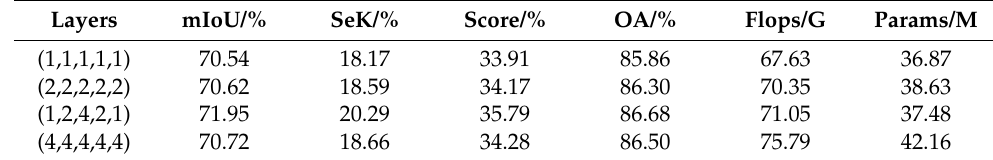
Figure 9. Visual comparisons of ablation experiment on the SECOND dataset. ( a ) images, ( b ) GT, ( c ) baseline model, ( d ) base + ℒ mul , ( e ) base + ℒ mul + PRTB, and ( f ) base + ℒ mul + PRTB + MCFM. We highlight interesting regions with orange boxes. Table 4. The effect of the n -layer transformer block on the SECOND dataset.